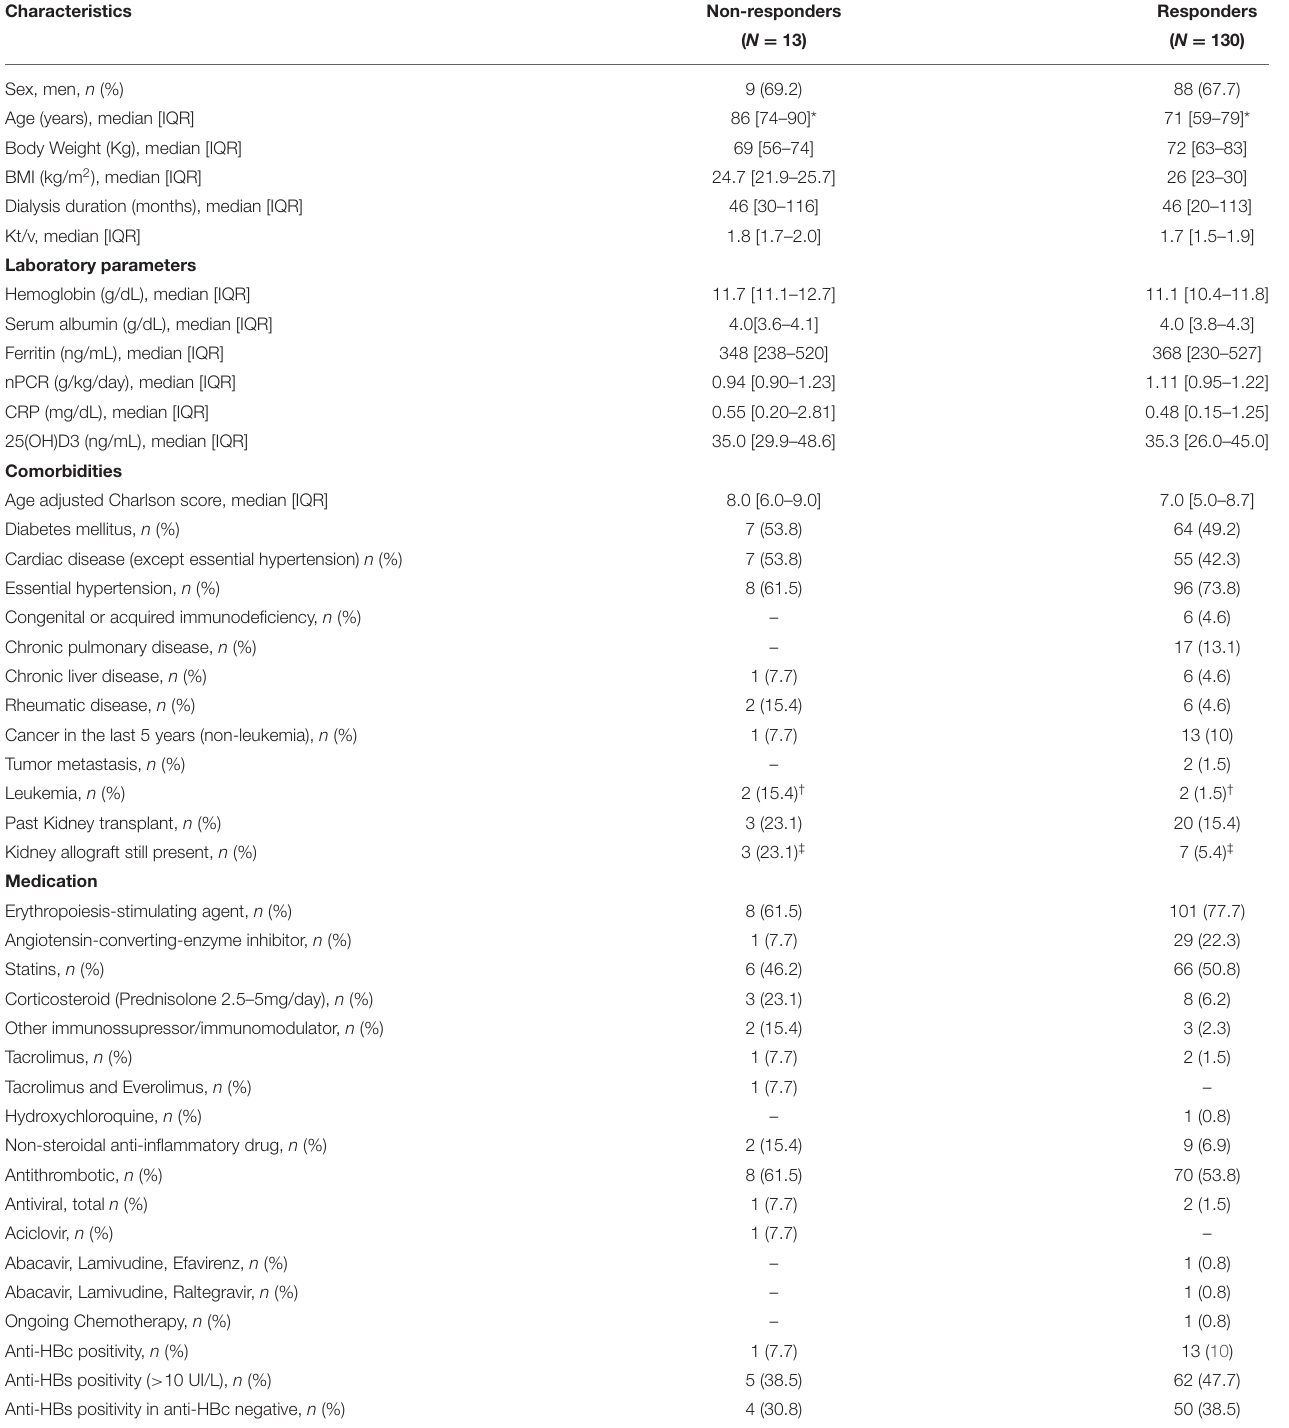
TABLE 1 | Clinical characterization of HD patients classified as non-responders or responders according to anti-spike IgG levels at t2.